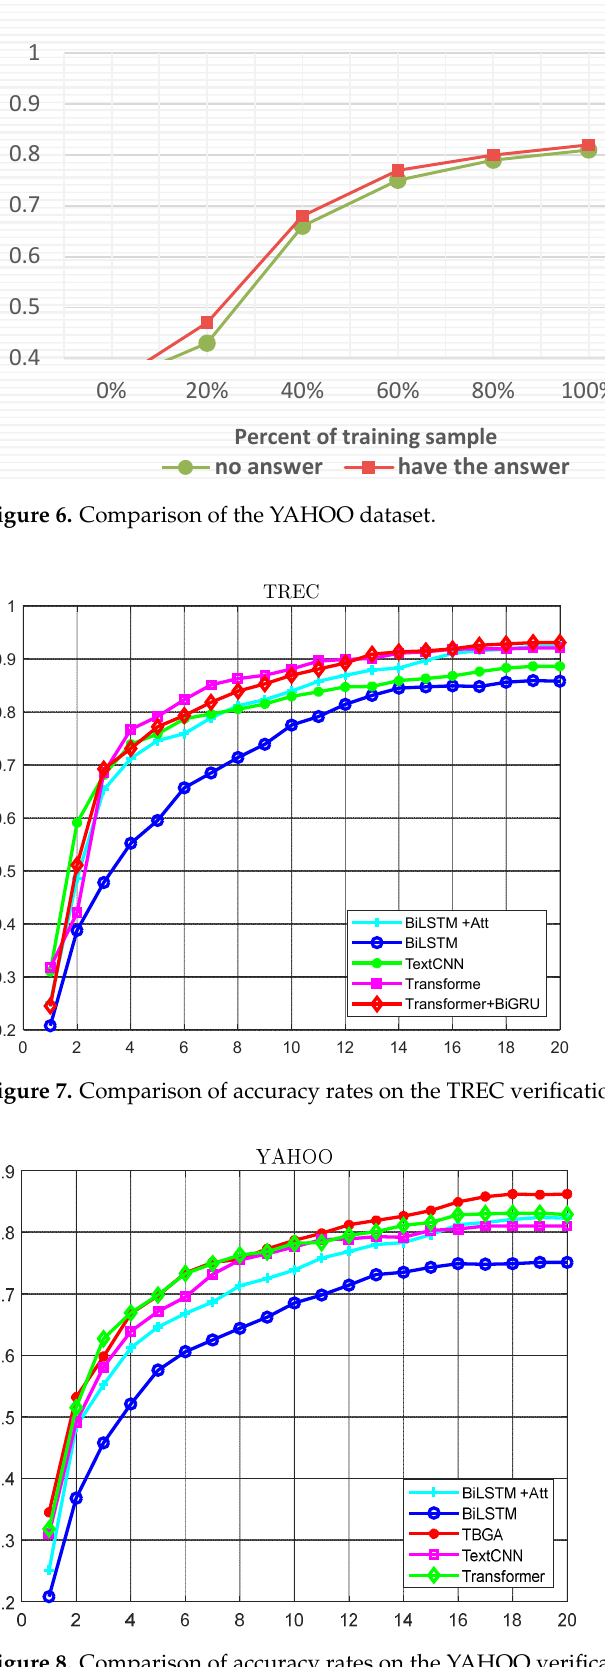
Figure 9. Comparison of accuracy rates on the OQA verification set.